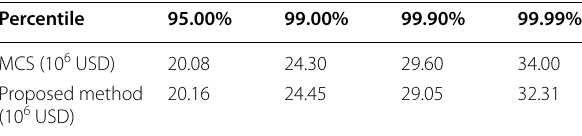
Table 2 Different percentiles obtained by the proposed method and MCS